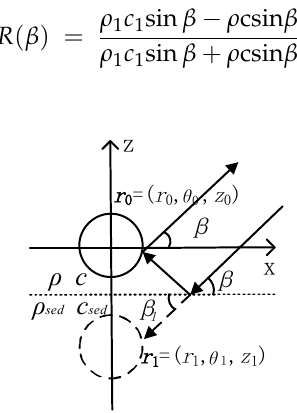
Figure 6. The acoustic wave around the spherical OBS placed on seafloor.